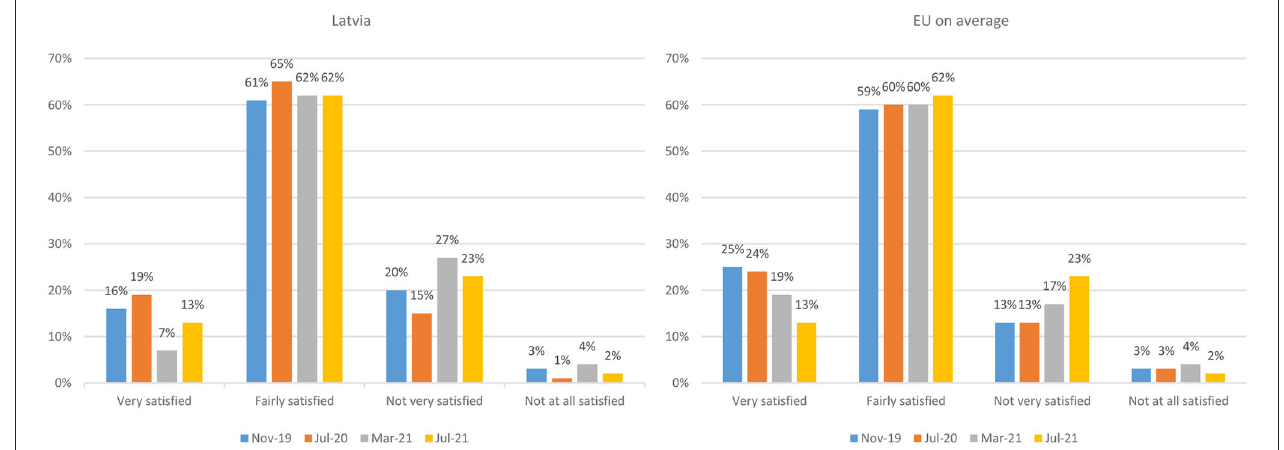
FIGURE 3 | Personal satisfaction with the life people lead, percent of respondents, 2019-2021 (9). Source: Standard Eurobarometer 92.3, 93.1, 94.3,